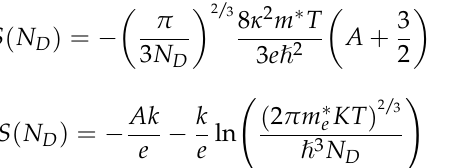
Table 3. Fitting results of output calibration polynomial of In 2 O 3 /ITO thin film thermocouple.